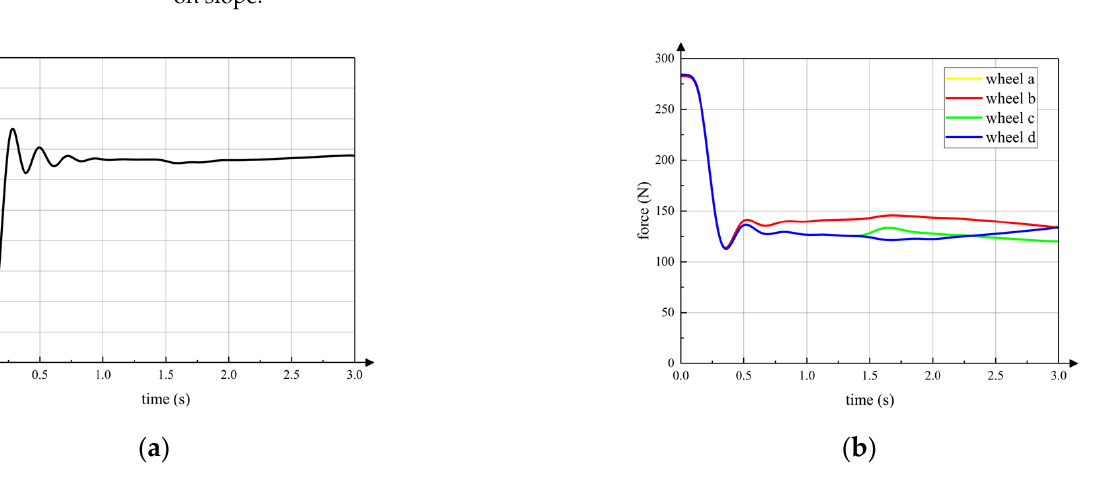
Figure 16. Simulation of wheeled motion (unilateral passive wheels on slope). ( a ) no wheel on slope; ( b ) front wheel on slope; ( c ) front wheel on slope and active wheel on flat ground; ( d ) two wheels on slope.